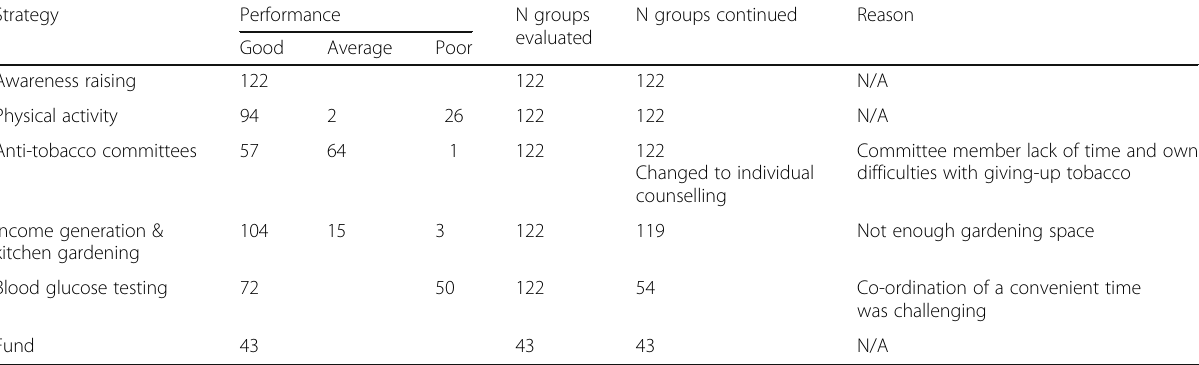
Table 3 Evaluated